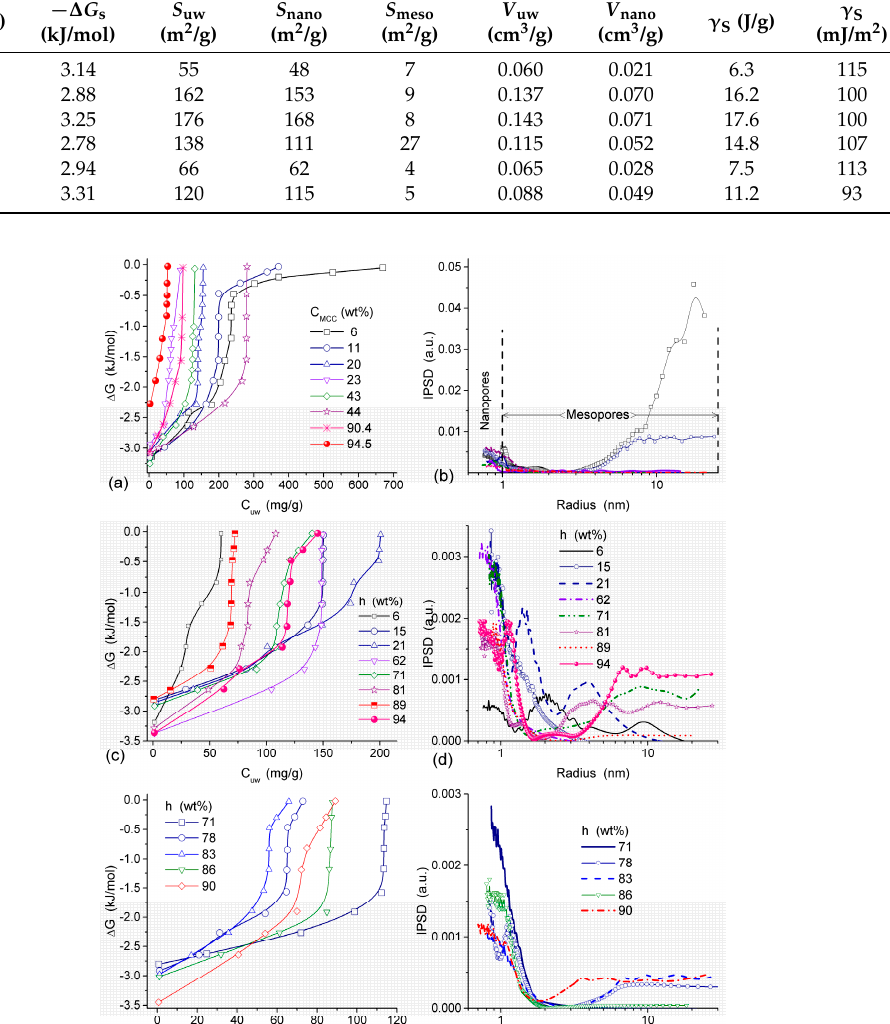
Figure 18. ( a , c , e ) Relationships between the amounts of unfrozen water and changes in the Gibbs free energy and ( b , d , f ) the corresponding PSD (NMR cryoporometry with GT equation at k GT = 67 K nm) for ( a , b ) MCC, ( c , d ) MCC/A-300 (5.6:1), and MCC/TiO 2 (3:1) (adapted from [13]). Table 6. Parameters of interfacial water for pure silica and silica/PVP suspensions ( C SiO2 = 6 wt %).